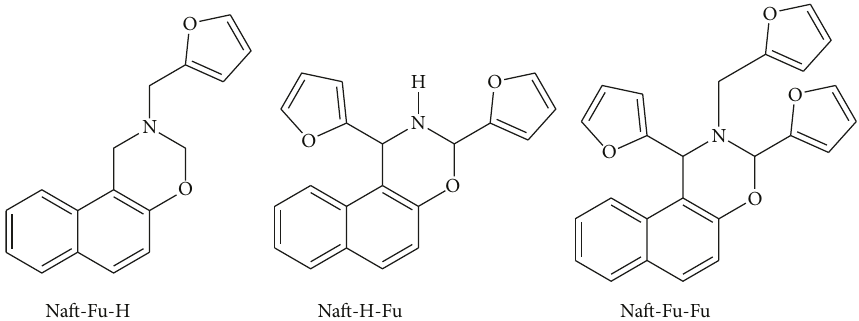
Figure 1: Naphthoxazines containing furan groups studied in this